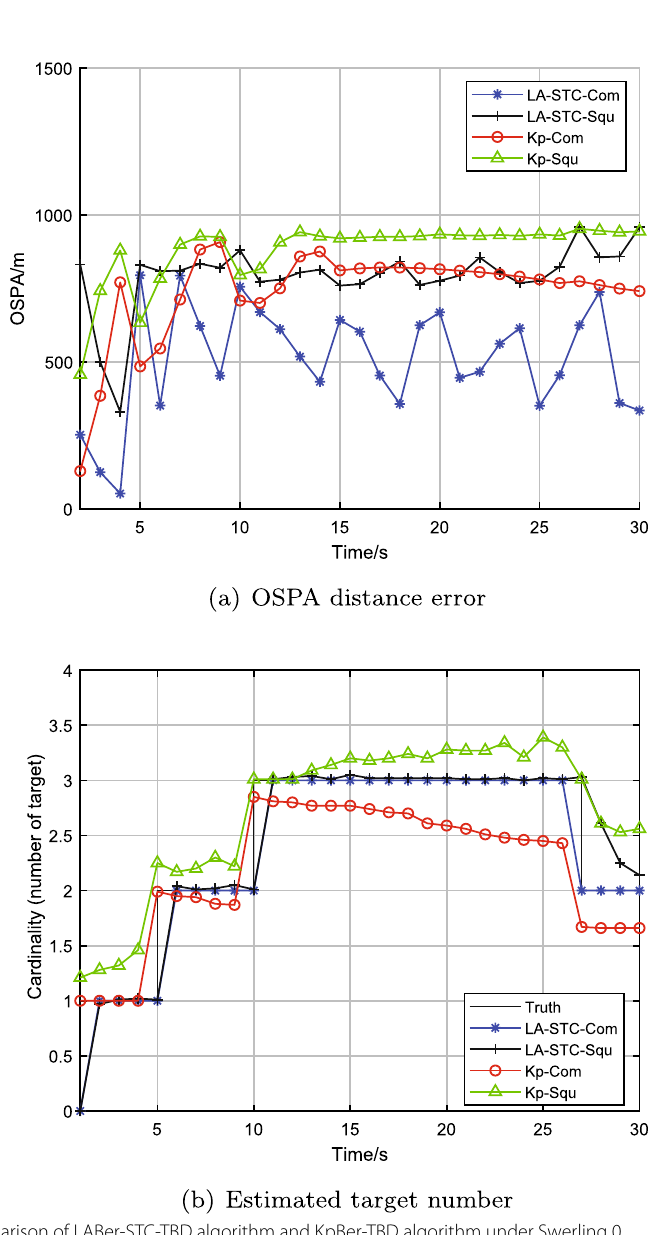
Fig. 6 Comparison of LABer-STC-TBD algorithm and KpBer-TBD algorithm under Swerling